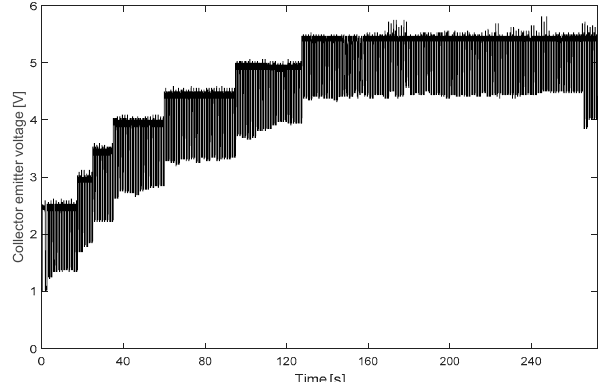
Figure 7. The collector-emitter voltage signal ending with IGBT burns out.